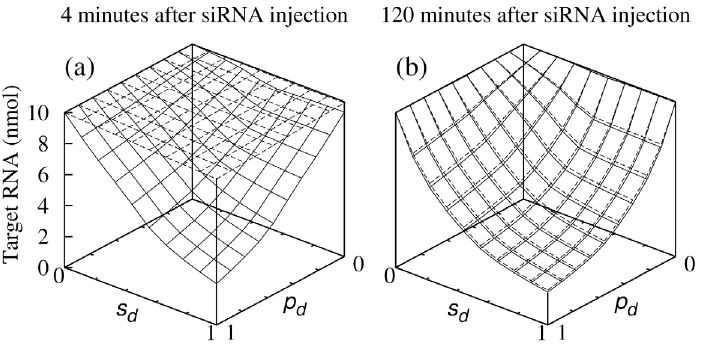
Fig 2. Density of target RNA as a function of s d and p d . Density of target RNA (a) 4 minutes and (b) 2 hours (b) after siRNA injection. Dashed lines, target in nucleus; solid lines, target in perinuclear region. Values shown are averaged over region where target